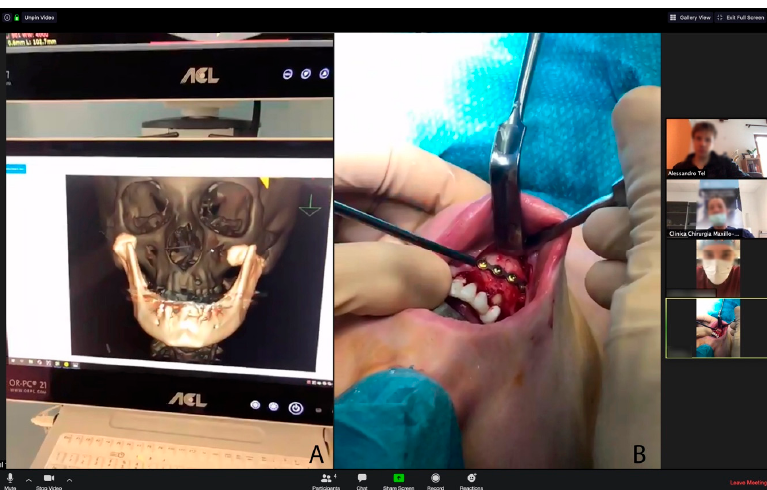
Figure 3. Videosurgery transmitted from the operating theatre. ( A ) Radiology images are viewed using an online consultation system. The presented image portrays a case of left condylar fracture associated to a right parasymphiseal fracture. ( B ) Surgical phases are conducted under the virtual guidance of a more expert surgeon. This phase shows the synthesis of the parasymphyseal fracture.